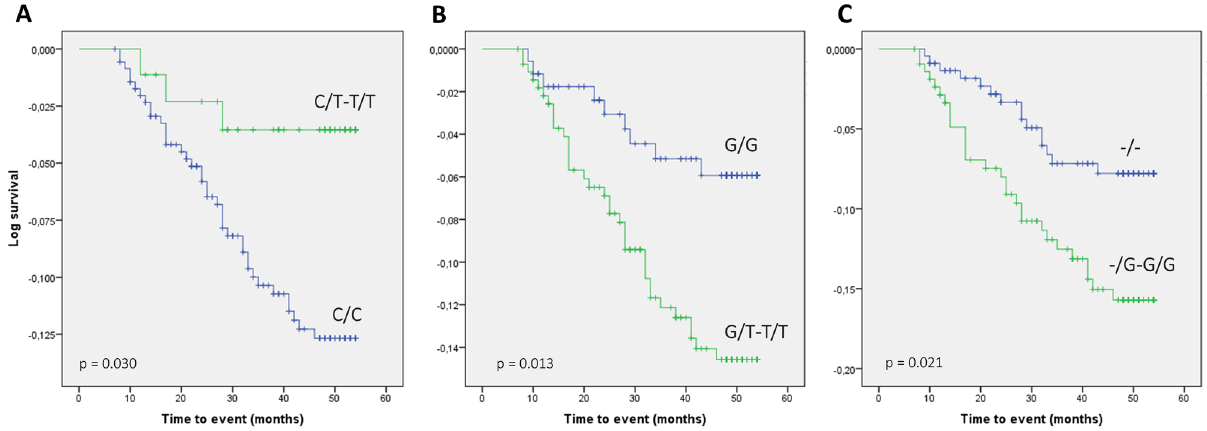
Figure 2. Kaplan–Meier curves for the association of PTGS2 rs4648268 ( A ), PTGES3 rs2958155 ( B ) and PTGES3 rs11300958 ( C ) with cardiovascular event-free survival. Wild type homozygous vs. variant genotypes are depicted. P-values for the long-rank tests carried out for comparison of the different genotypes are shown. The rs11300958 polymorphism produces an insertion